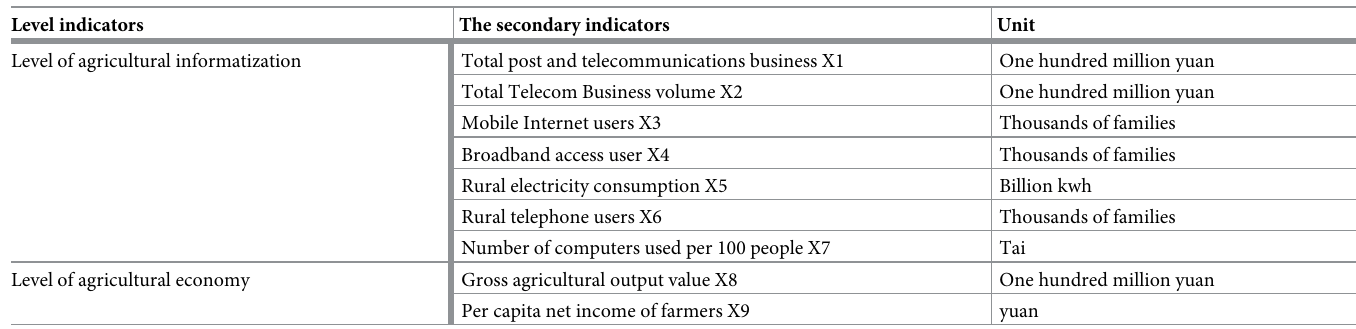
Table 2. Evaluation index system.